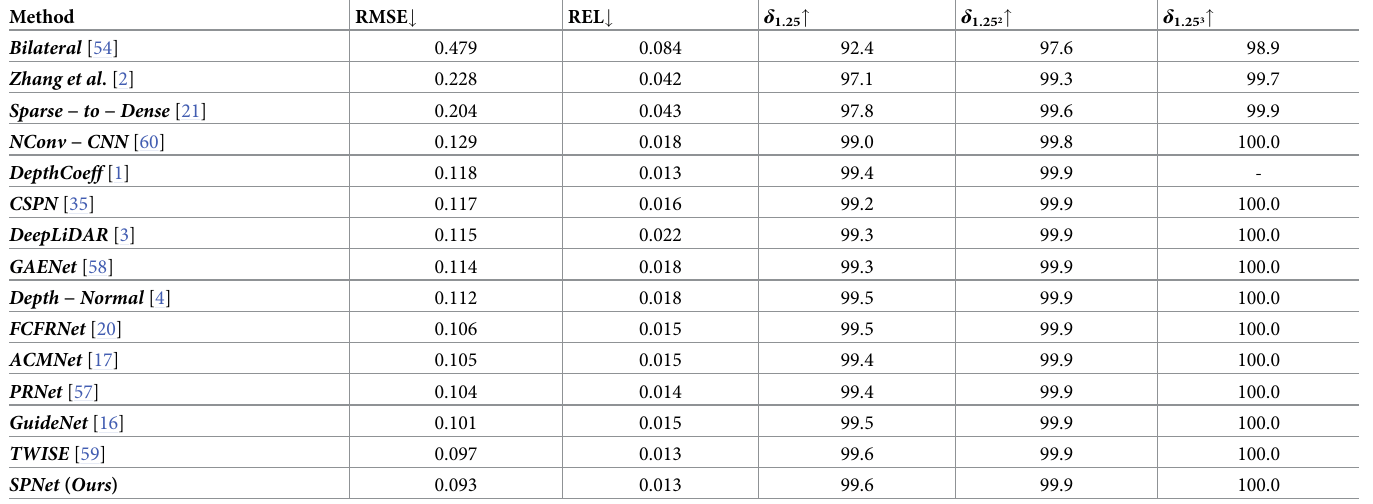
Table 1. Quantitative comparison on NYU Depth v2